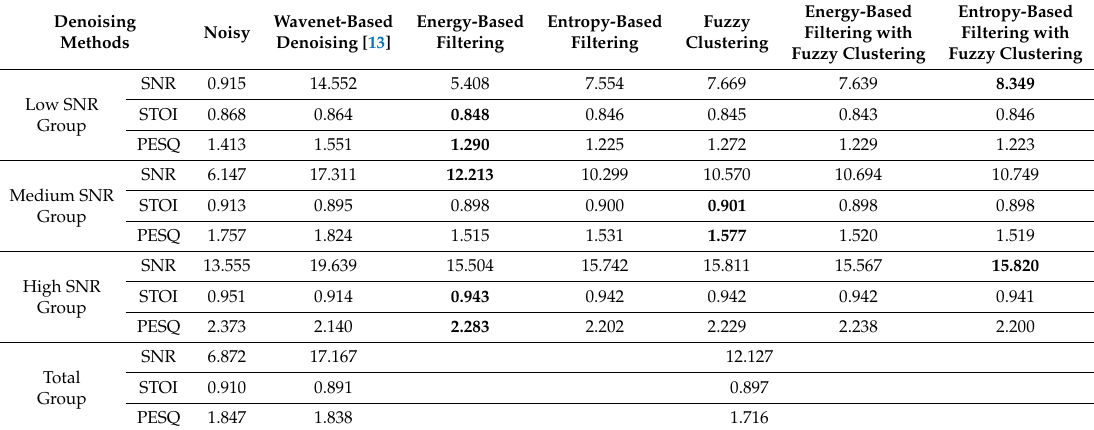
Table 4. The comparison of denoising performance for both speech and non-speech segments.